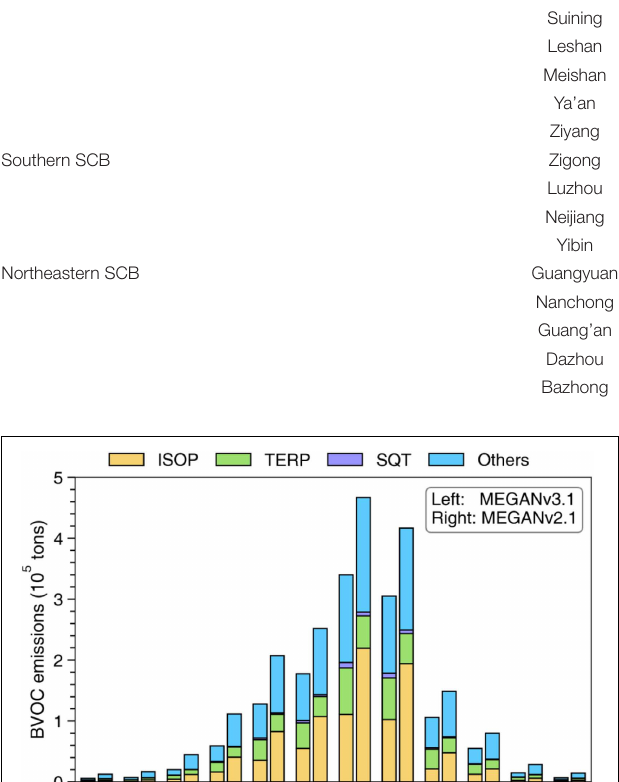
were 7.3 × 10 5 (41.1% of total BVOCs), 2.4 × 10 5 (13.5%), 2.3 × 10 4 (1.3%), and 7.9 × 10 5 (44.1%) tons, respectively. In contrast, MEGANv3.1 estimated 3.6 × 10 5 tons for ISOP (29.7% of total BVOCs), 3.0 × 10 5 tons for TERP (24.8%), 2.9 × 10 4 tons